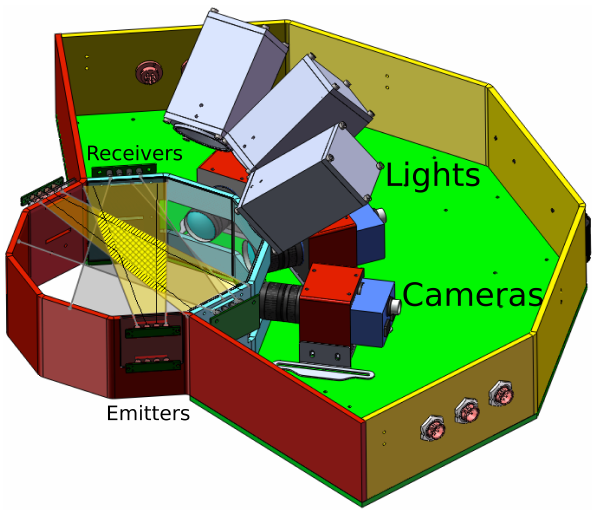
Fig. 1. Schematic of the basic components of the Multi-Angle Snowflake Camera. The hatched region represents the cross section for triggering of the near-infrared motion detector system.